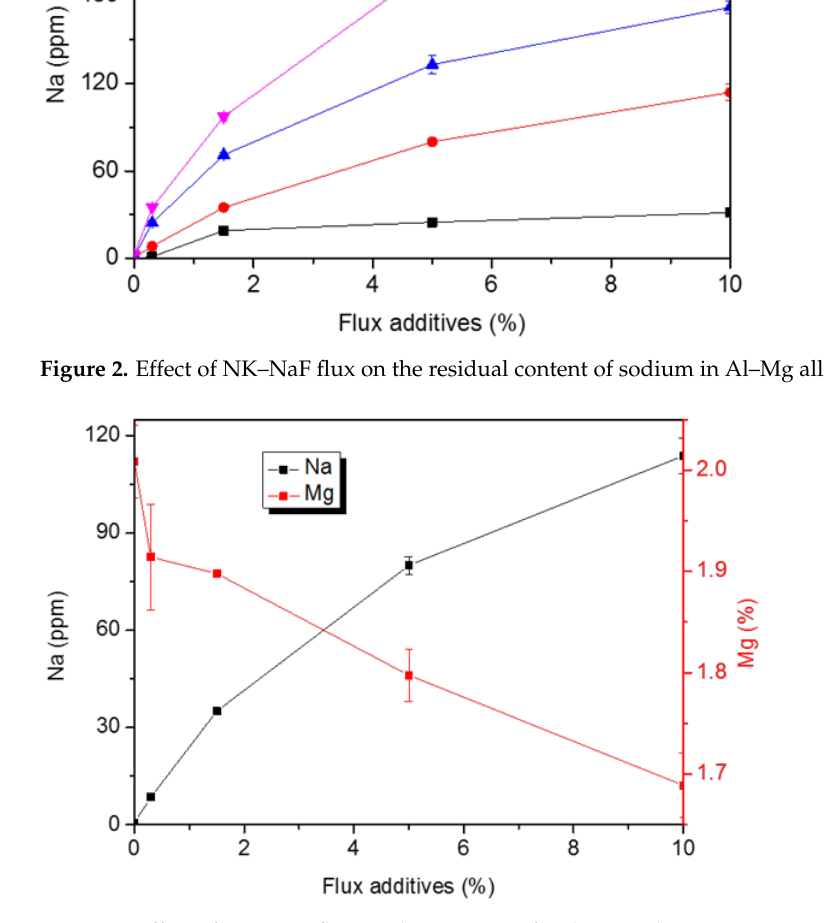
Figure 3. Effect of NK – NaF flux on the contents of sodium and magnesium in Al – 2Mg alloy.